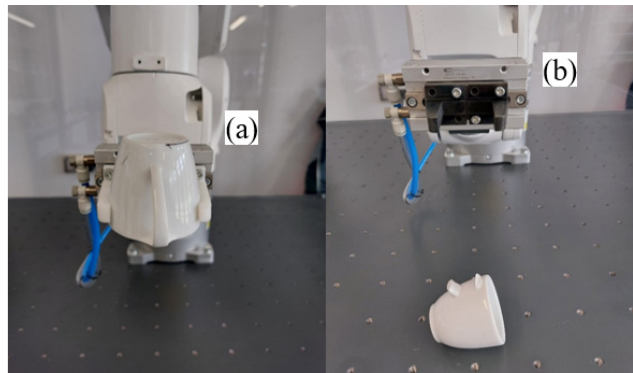
Figure 9. Test with special profile tweezers ( a ) and standard tweezers ( b ). Source: